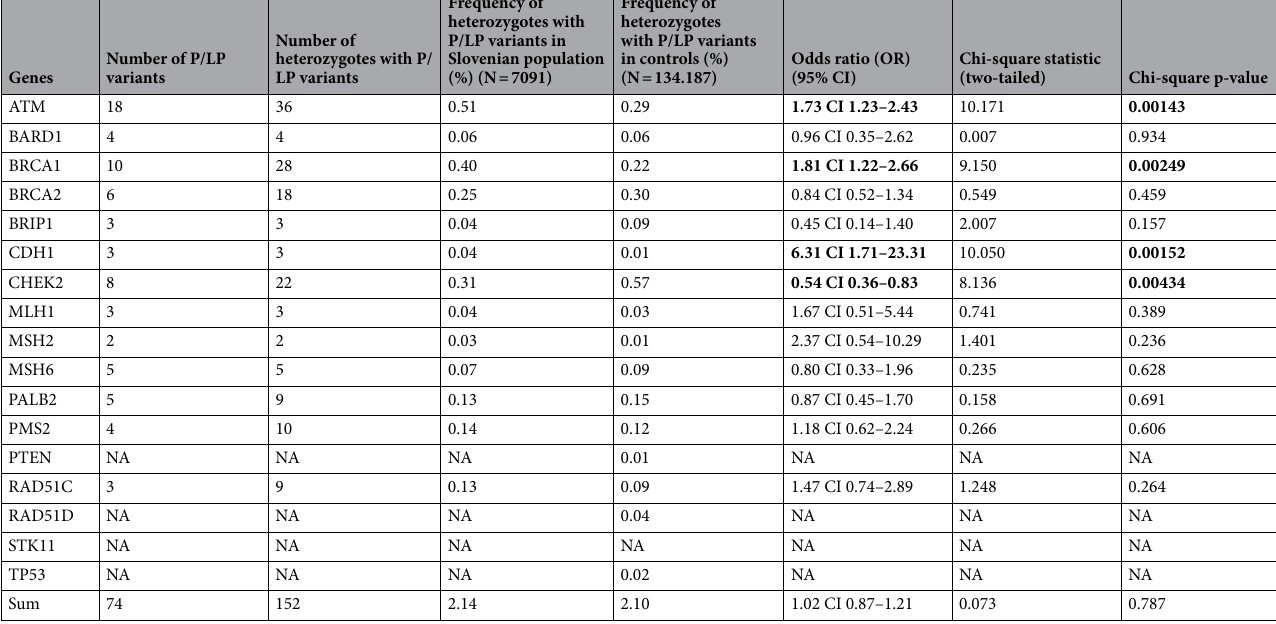
Table 2. Pathogenic and likely pathogenic variants in the Slovenian population in 17 gynecologic cancer genes. P/LP pathogenic/likely pathogenic, OR odds ratio, CI confidence interval. Statistically significant differences are in